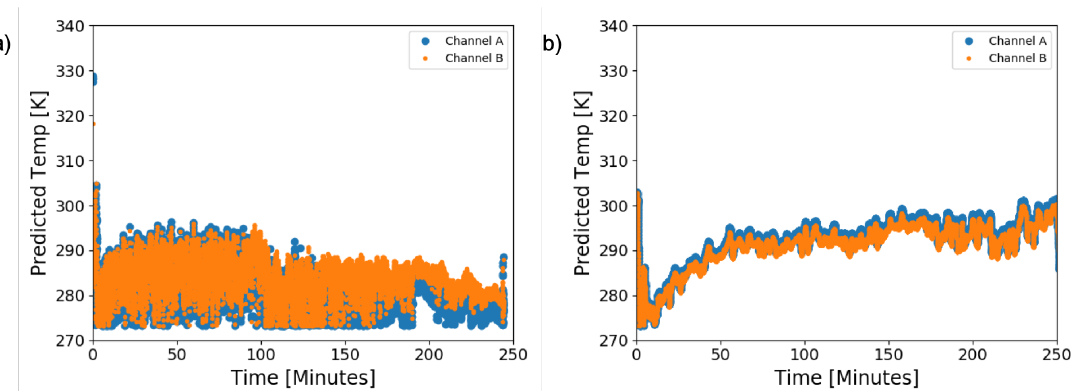
Figure 4. ( a ) Field collected data during a Landsat pass without wind protection or insulation for solar loading. ( b ) Field collected data with wind protection and insulation integrated into the prototype radiometer